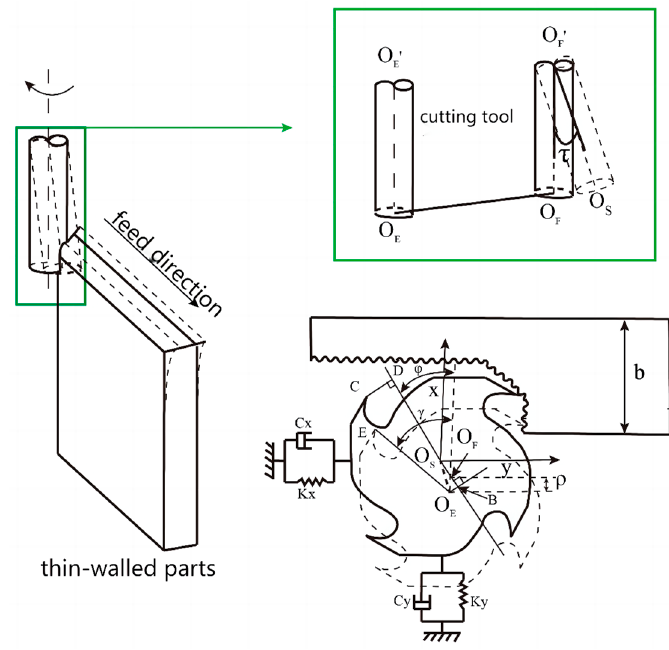
Figure 3. Milling model of thin-walled workpiece considering tool runout.